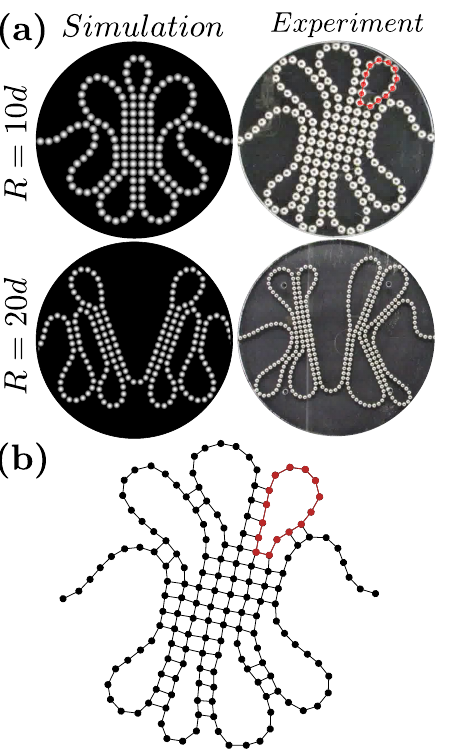
Figure 1. (a) Patterns obtained injecting wires of magnetic beads from opposite sides. First column: simulations using a molecu- lar dynamics method (MD). Second column: experiments per- formed for two di ff erent cavity radii, namely, R = 10 d and R = 20 d . (b) Contact network (graph) of the pattern obtained in a cavity of R = 20 d radius. Edges are established when the distance between the centers of the spheres are less than or equal to the sphere diameter. A typical loop is highlighted in red. Figure 2. Log-log plot of ( a ) number of loops N l and ( b ) number